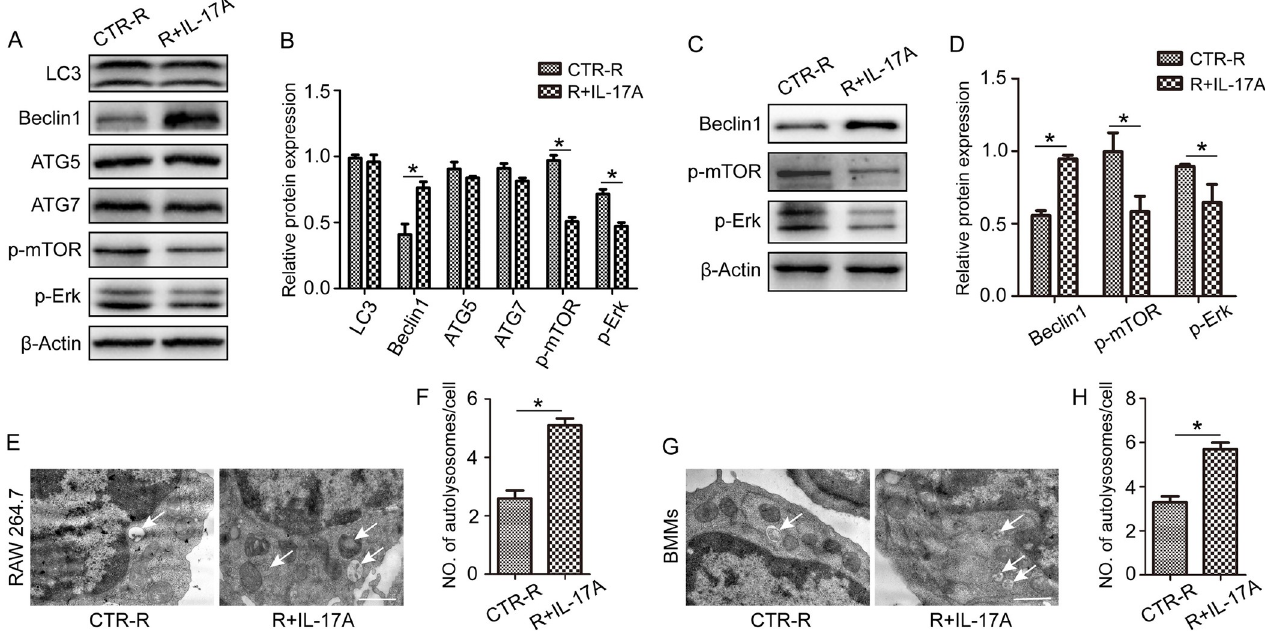
Fig 3. IL-17A promotes OCP autophagy through the ERK/mTOR/Beclin1 pathway induced by RANKL. RAW 264.7 cells and BMMs were stimulated with or without IL-17A (1 ng/ml) in the presence of RANKL (50 ng/ml) for 24 h. (A, C) Autophagy-related proteins were detected by western blotting and (B, D) protein expression was normalized against β -Actin. (E, G) TEM images and (F, H) numbers of autolysosomes (arrows) in RAW 264.7 cells and BMMs after treatment with or without IL-17A (1 ng/ml) for (A) 1 d in the presence of RANKL (50ng/ml). At least 60 cells were observed. Cells not treated with IL-17A but exposed to RANKL (CTR-R) were used as control. Data are presented as the mean ± SD from three independent experiments. � p < 0.05. Scale bar, 1 μ m.